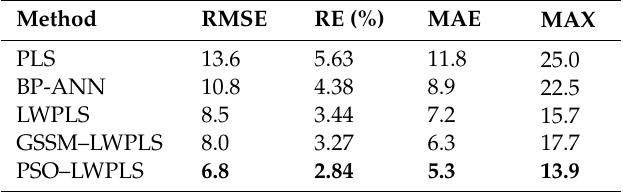
Table 3. Statistical analysis of TS prediction errors. BP-ANN: back-propagation artificial neural network.